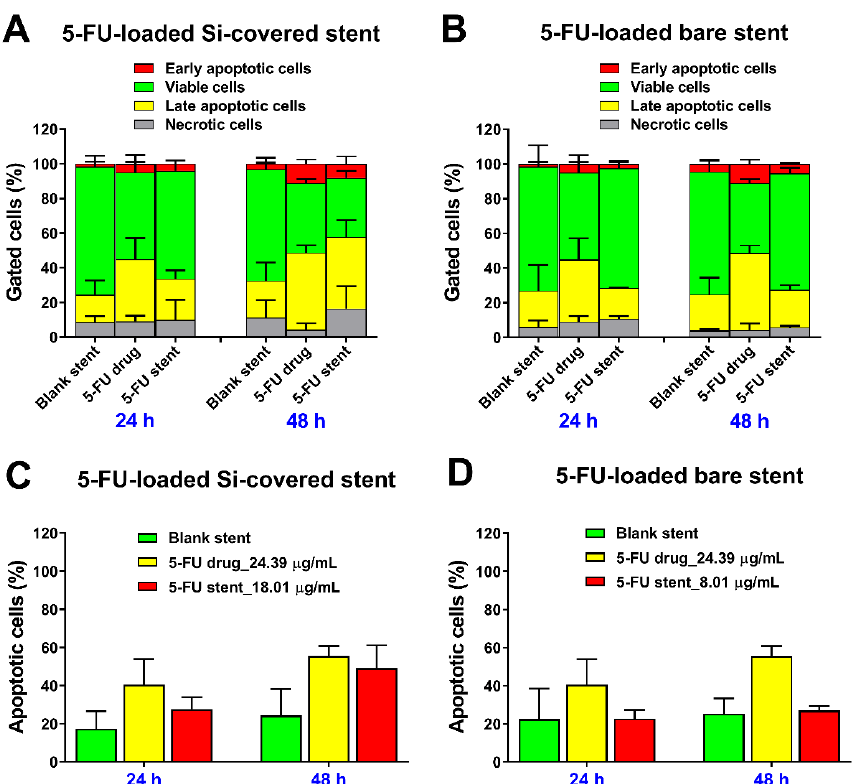
Figure 11. Evaluation of in vitro anticancer effect of 5FU released from the ( A , C ) Si-PU 5FU -PEVA and ( B , D ) B-PU 5FU -PEVA stent sections at 24 and 48 h on HCT-116 human colon cancer cells; determined by flow cytometric analysis. ( C , D ) Total apoptotic cells were calculated by adding the early and late apoptotic cells. All data represent mean ± SD from at least two replicate measurements, without subtracting the value of untreated control (media).